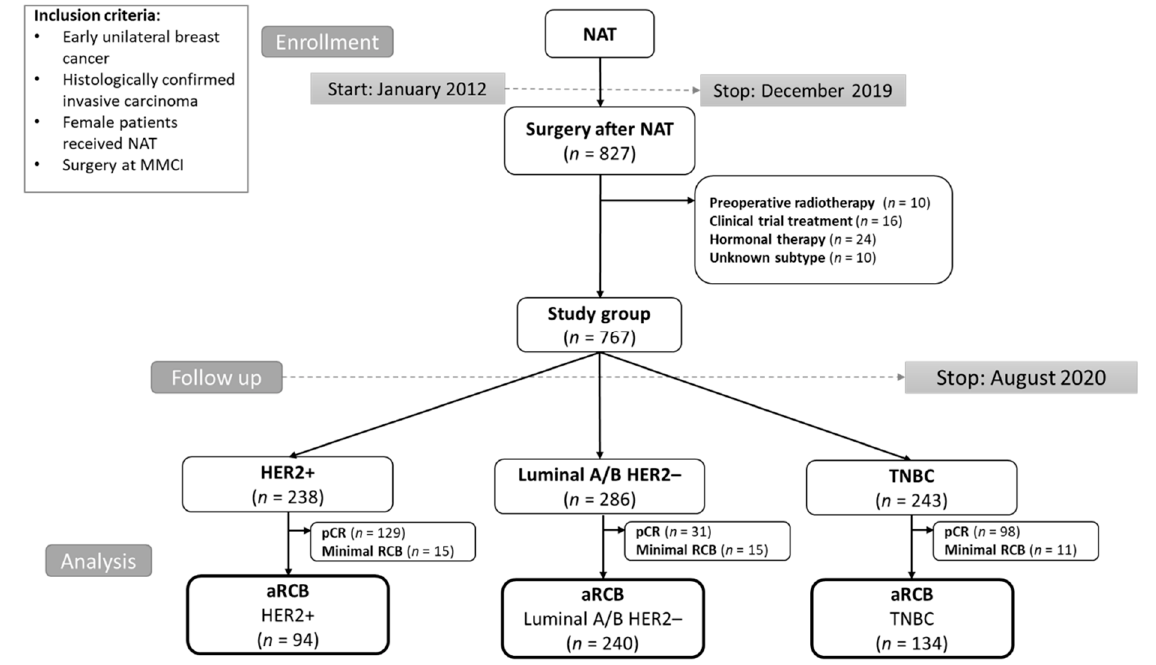
Figure 1. CONSORT diagram of the study population. Abbreviations: MMCI, Masaryk Memorial Cancer Institute; NAT, neoadjuvant therapy; TNBC, triple-negative breast cancer; HER2, human epidermal growth factor receptor 2; pCR, pathological complete response; aRCB, assessable residual cancer burden.